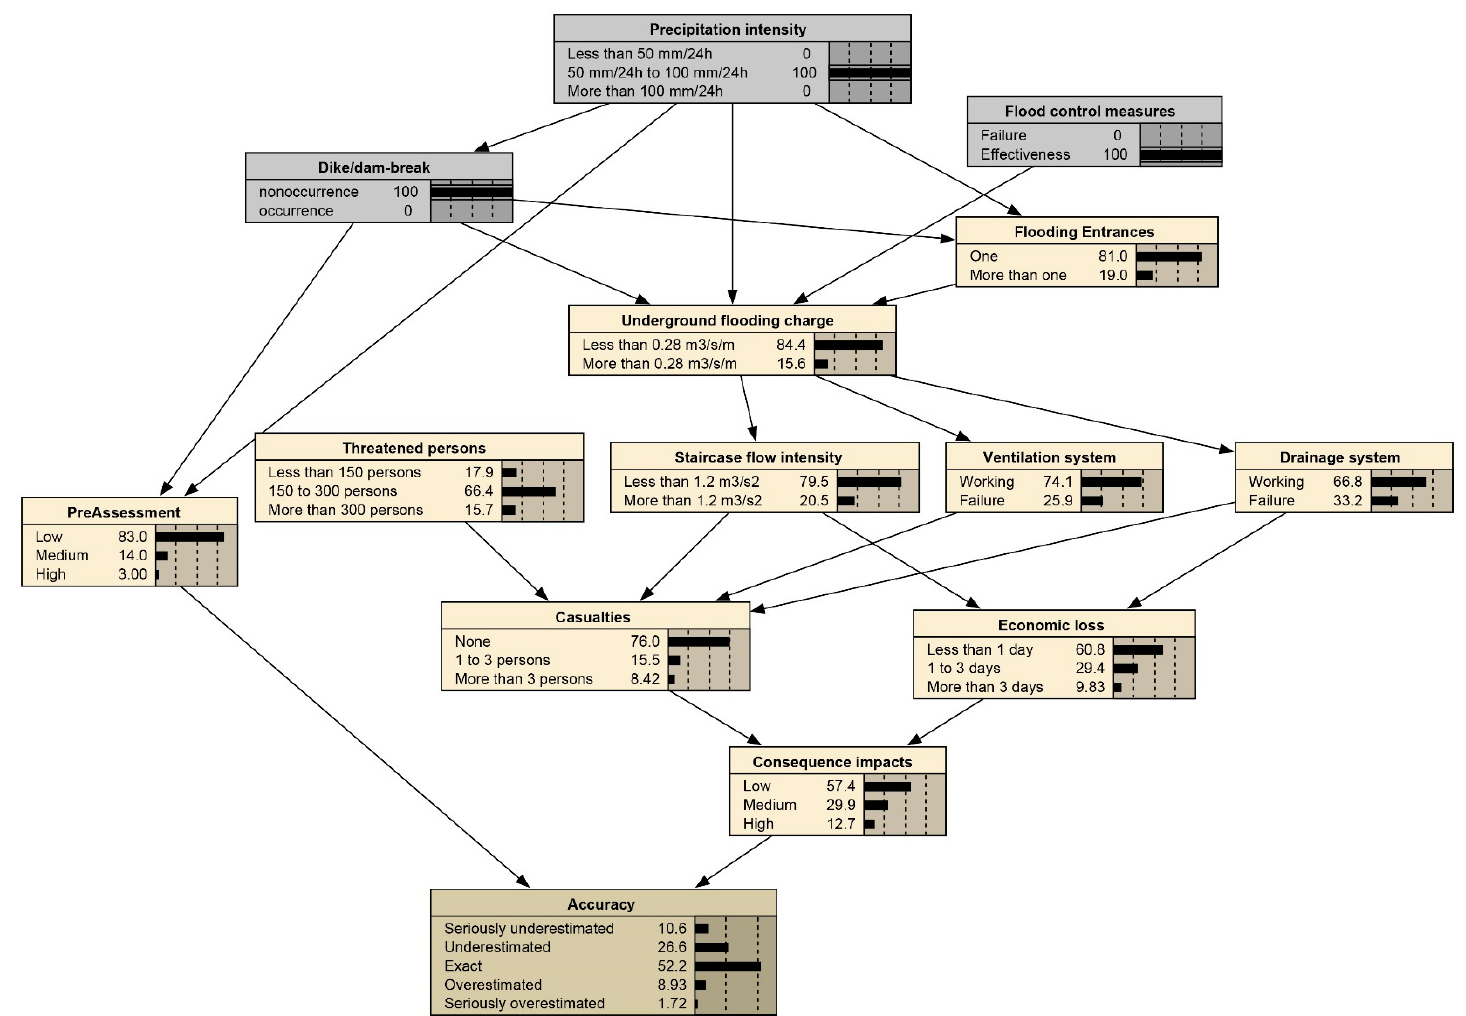
Figure 6. Inference results with pre-assessment (no dike/dam break).